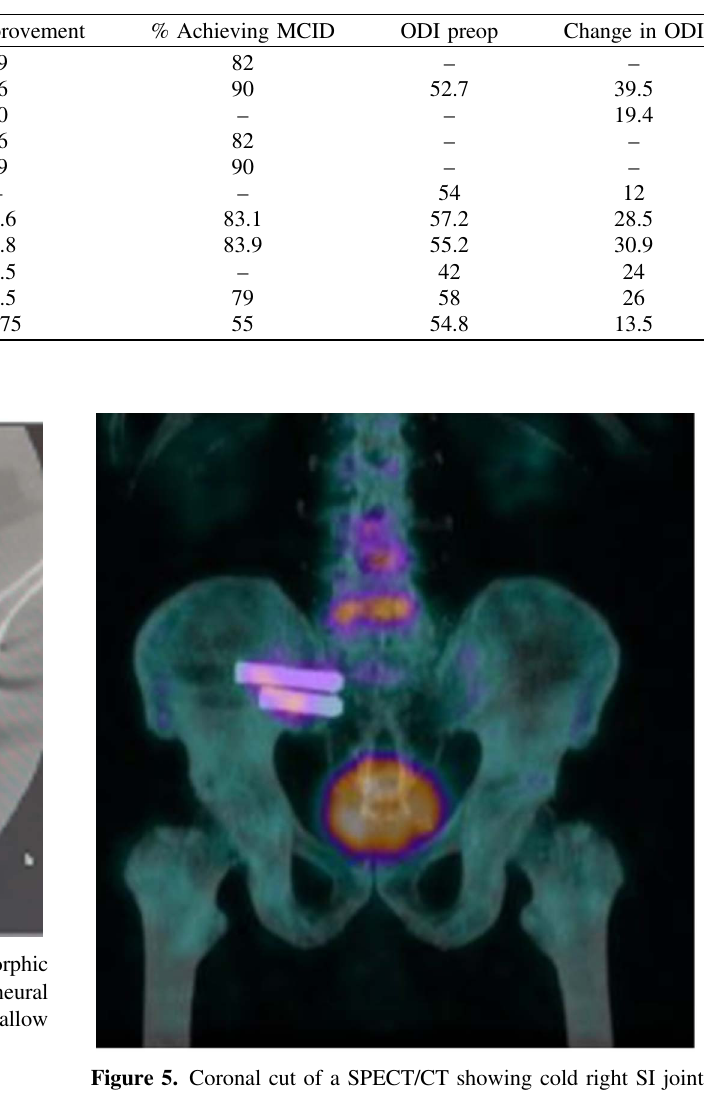
Table 3. List functional outcome reported on MI SI fusion using iFuse implant.